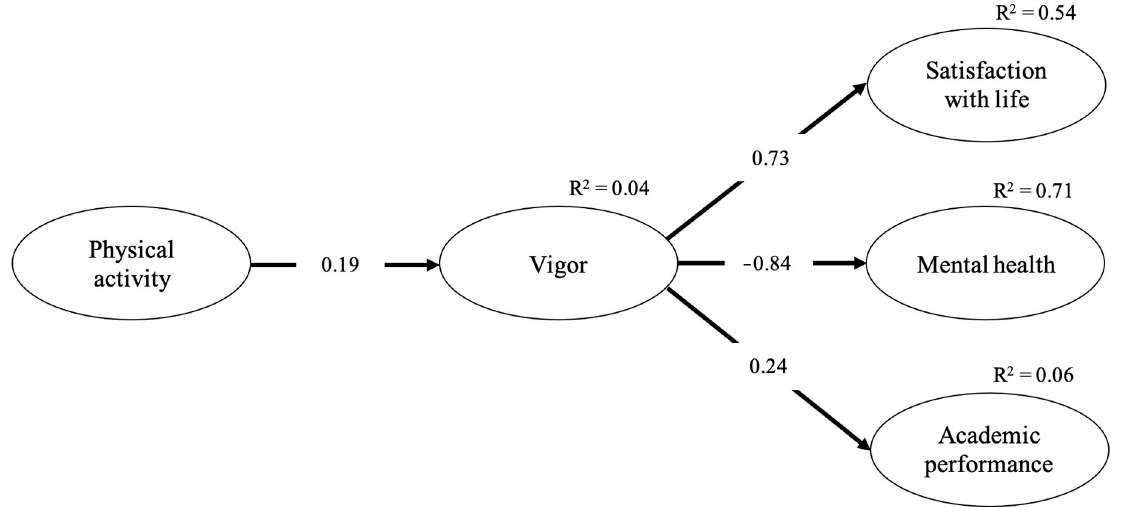
Figure 1. Estimated standardized regression and squared multiple regression (R 2 ) coefficients for Model 2 (no direct effect). Note. All estimated standardized regression and squared multiple regression (R 2 ) coefficients were significant .